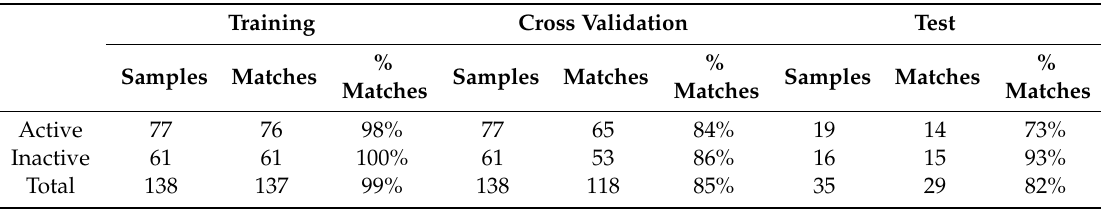
Table 1. Summary of integral training, cross-validation and testing with the corresponding match results using the random forest (RF) algorithm.